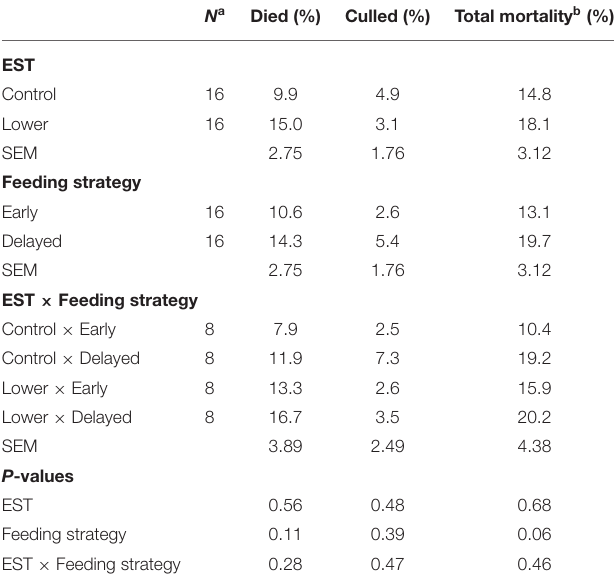
TABLE 1 | Effect of eggshell temperature ( EST ) during late incubation [ ≥ E17–E19.5; 37.8 ◦ C ( control ) or 36.7 ◦ C ( lower )] and/or feeding strategy after hatch [immediate access to feed and water ( early ) or 51–54-h deprivation ( delayed )] on mortality of broilers during 2 weeks following necrotic enteritis induced at d 21 post hatch (LSmeans ±